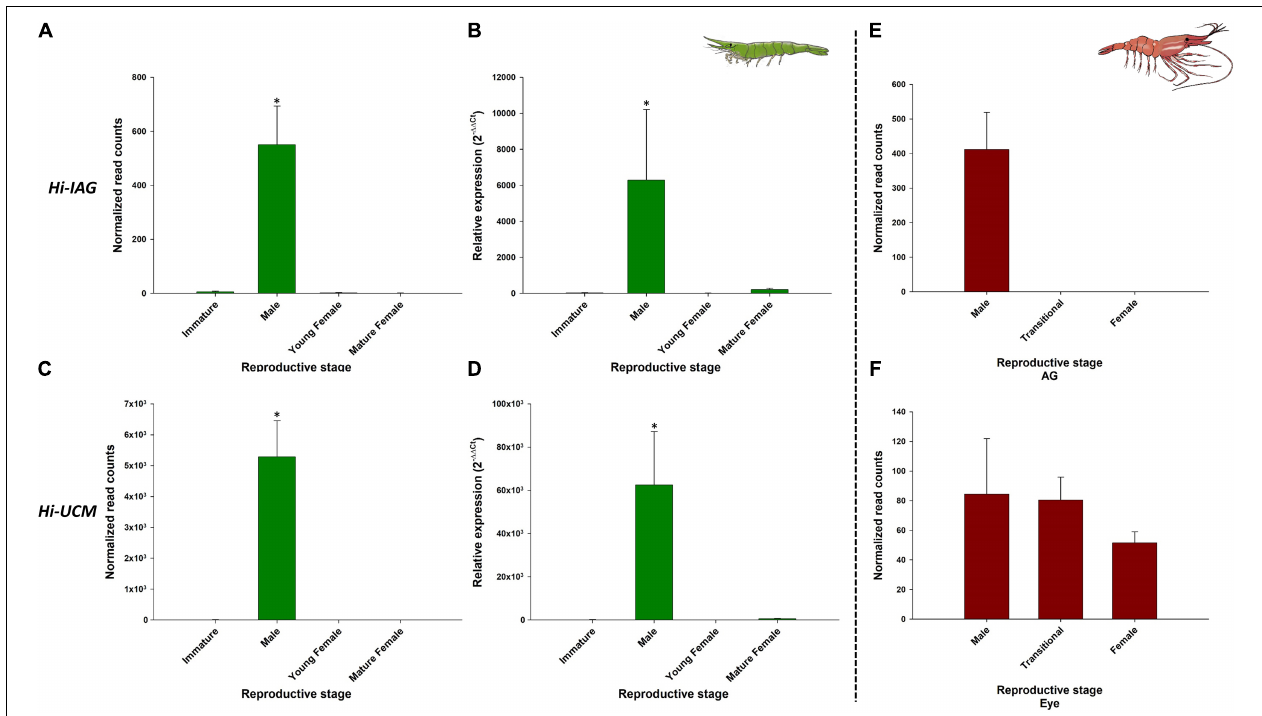
FIGURE 7 | Representative male-related genes in Hippolyte inermis and their homologs in Pandalus platyceros . Left panel - Male related genes in different stages of H. inermis : immature ( n = 3), male ( n = 3), young female ( n = 3) and mature female ( n = 3). (A) Normalized read counts of Hi-IAG . (B) Relative expression of Hi-IAG . (C) Normalized read counts of Hi-UCM . (D) Relative expression of Hi-UCM . Right panel – Hi-IAG and Hi-UCM homologs in different stages of P. platyceros : male ( n = 2), transitional ( n = 2) and female ( n = 2). (E) Normalized read counts of Pnp-IAG . (F) Normalized read counts of a Hi-UCM homolog. Read counts of the genes in P. platyceros were obtained from Levy et al. (2020a). Error bars represent standard error of the means. * P ≤ 0.05.